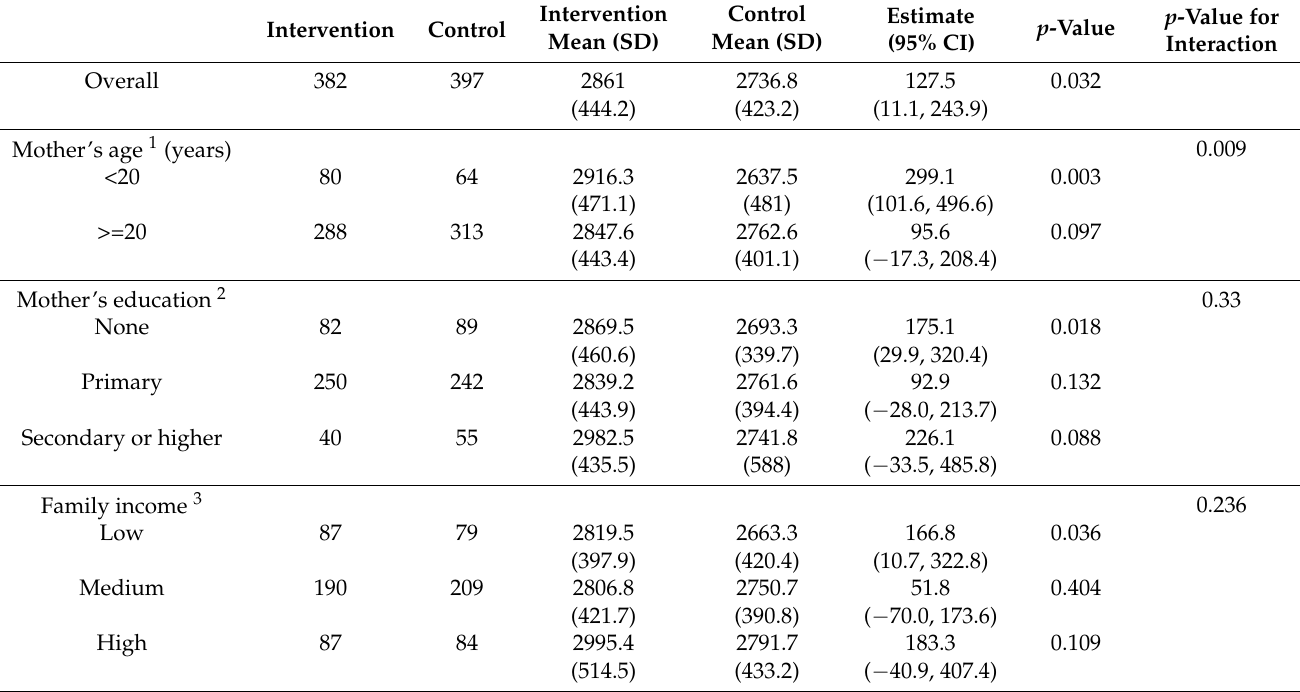
Table 2. The mean birth weight and the mean difference in birth weight of balanced-plate intervention compared to usual